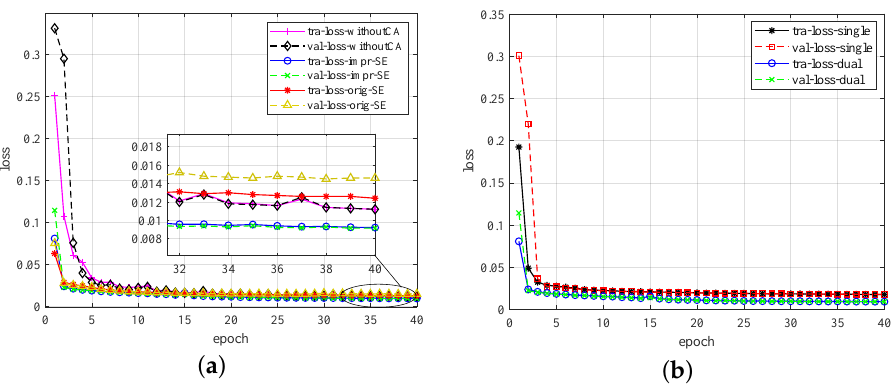
Figure 6. Ablation experiments. ( a ) Original SE and improved SE. ( b ) Single and dual residual connections. In the proposed DRdA-CA, “dual” represents the residual connections added not only between different encoding (decoding) blocks but also inside the encoding (decoding) blocks of different depths, so it is called “dual”. In contrast, “single” refers to the residual connection only existing inside the encoding (decoding) block, and each encoding (decod- ing) block is the improved SE-ResNet module, which contains one residual